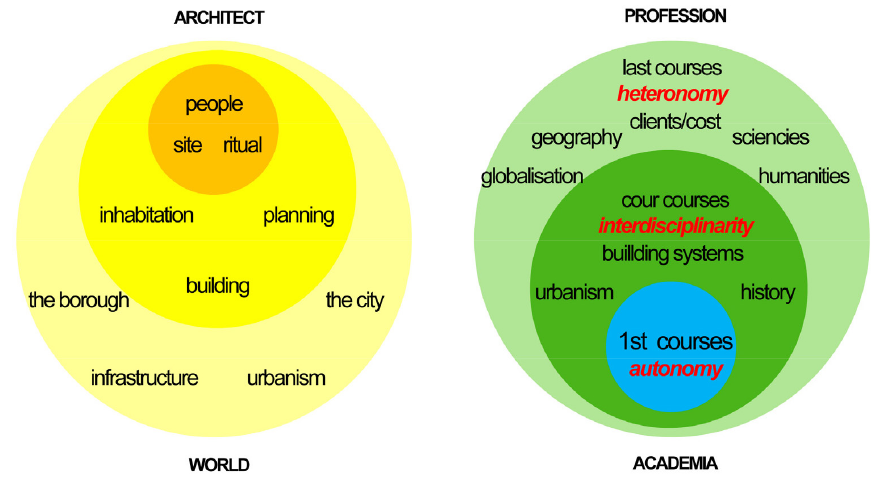
Figure 4. Spheres related to the teaching of